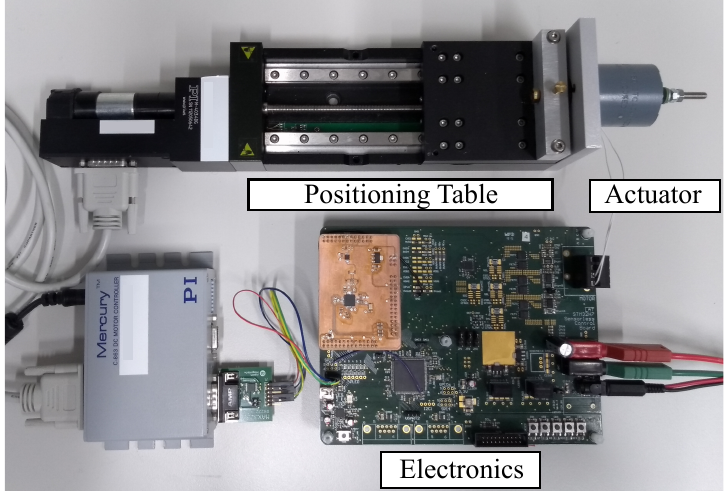
Figure 9. Experimental test-bench including positioning table, electronics, and test